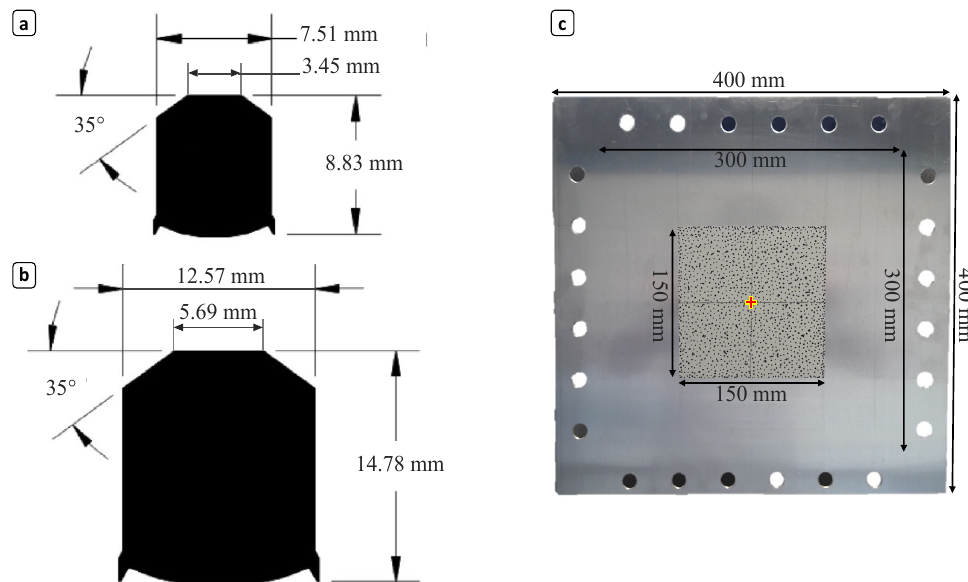
Figure 2. Dimensions of the fragment-simulating projectiles and the plate: ( a ) caliber 7.62 mm [22]; ( b ) caliber 12.7 mm [22]; ( c ) aluminum plate specimen with an exposed area of 300 mm × 300 mm and a spray-painted speckle pattern over an area of interest of 150 mm × 150 mm.